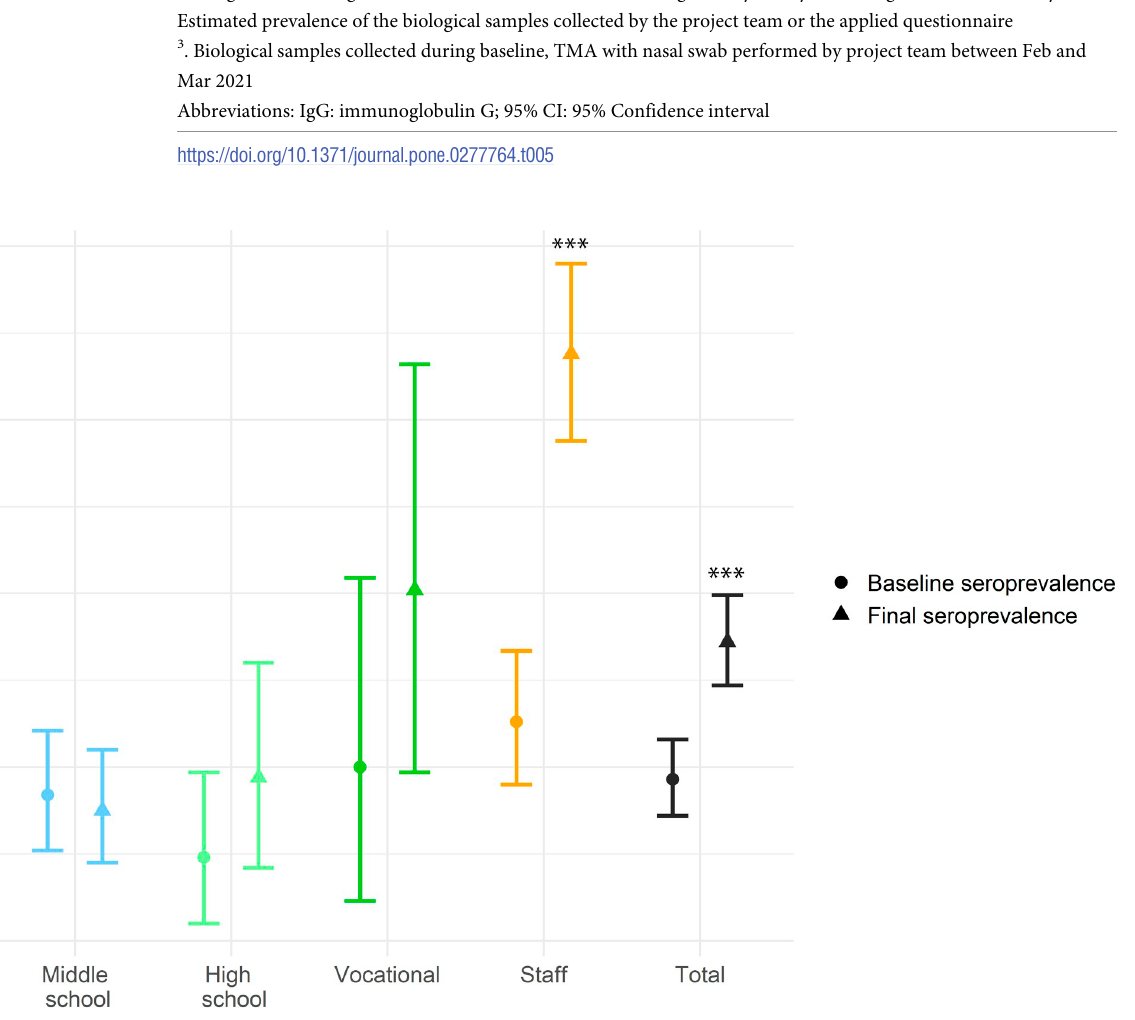
Fig 2. Adjusted seroprevalence of antibodies IgG anti-SARS-CoV-2 in longitudinal population by educational stages and school staff at the baseline (February-March 2021) and the last follow-up (May-June 2021). ��� p < 0.001 using McNemar test.